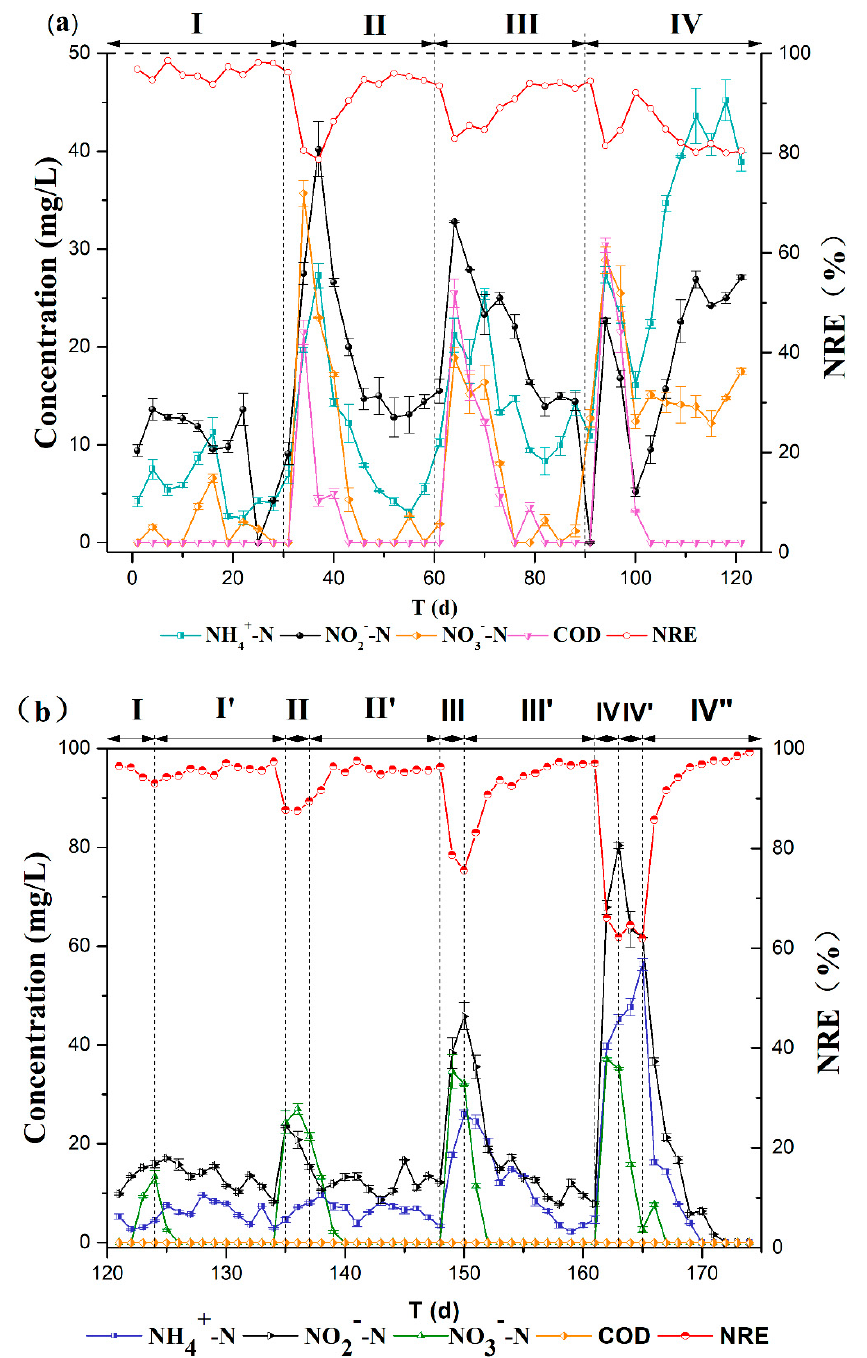
Figure 3. Operating performance of the A / SAD / HD system at stage I ( a ) and stage II ( b ); COD: chemical oxygen demand; NRE: nitrogen removal efficiency.